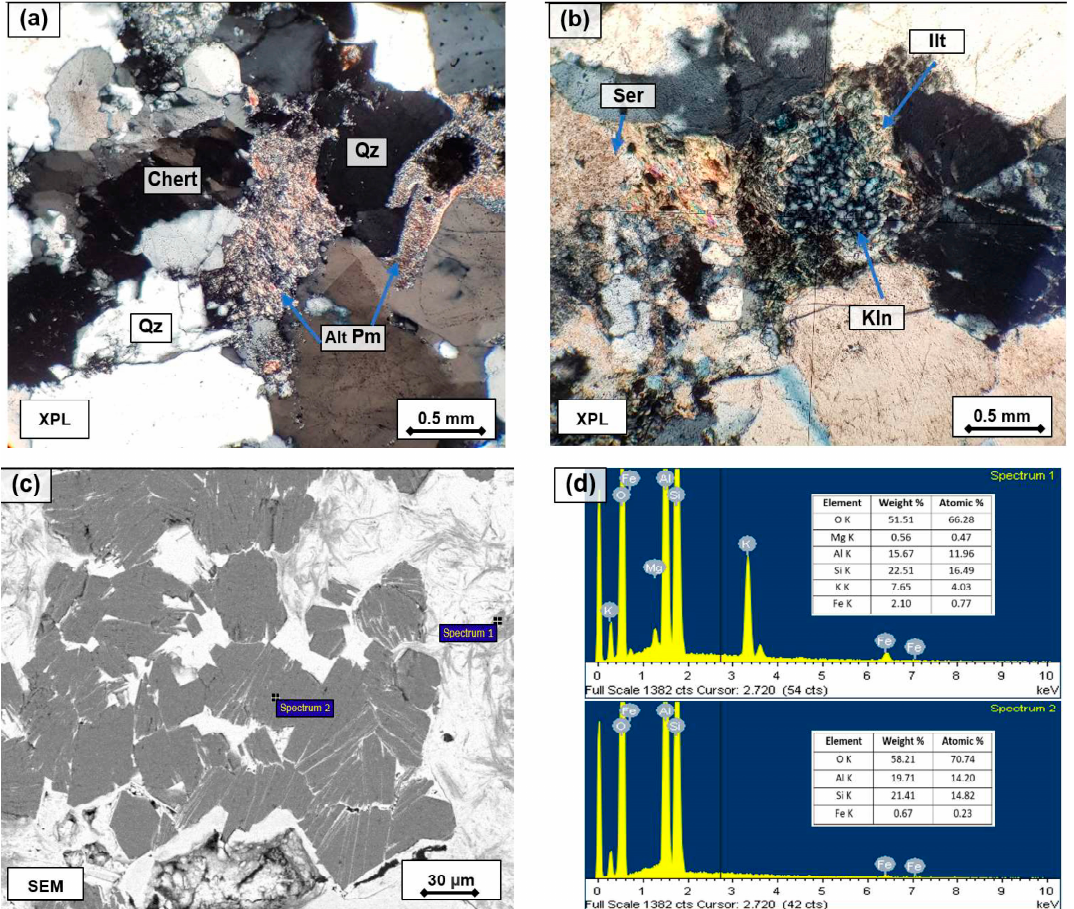
Figure 7. Rock matrix components. ( a ) Altered pseudomatrix squeezed among quartz and chert grains. ( b ) Authigenic clayey matrix found in the sample. Illite fibers stand out from their bright interference colors around the loose aggregates of kaolinite-group minerals, while sericite is frequently observed on the surface of sedimentary lithic fragments. ( c , d ) Illite and kaolinite-group minerals with their respective EDS signals. Alt Pm = altered pseudomatrix, Qz = quartz, Kln = kaolinite-group minerals, Ilt = illite, Ser = sericite, PPL = plane polarized light, XPL = cross polarized light, SEM = scanning electron microscope.